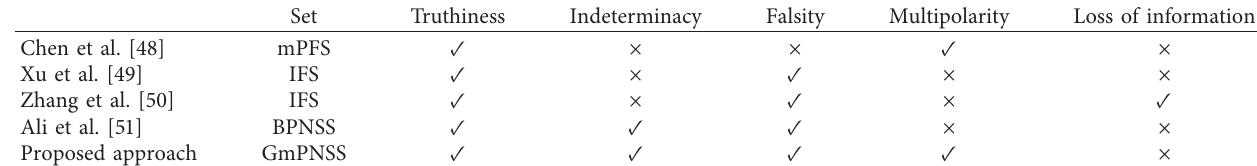
Table 8: Comparative analysis between some existing techniques and the proposed approach.